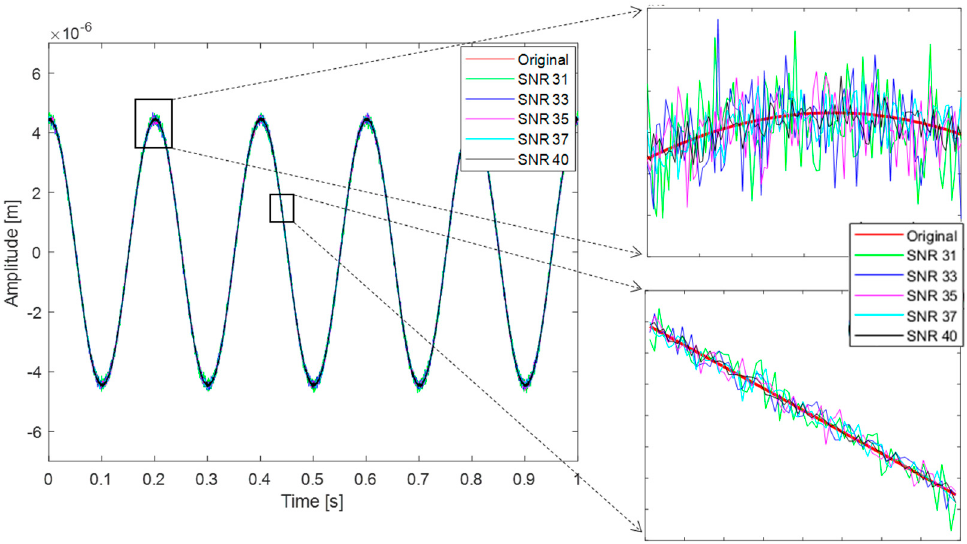
Figure 4. Effect of different values of sound-to-noise-ratio (SNR) on the signals obtained from the simulation model.